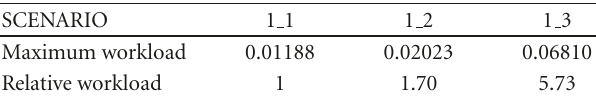
Table 7: Summary of performance evaluation 2 (st = 5 millisec- onds).